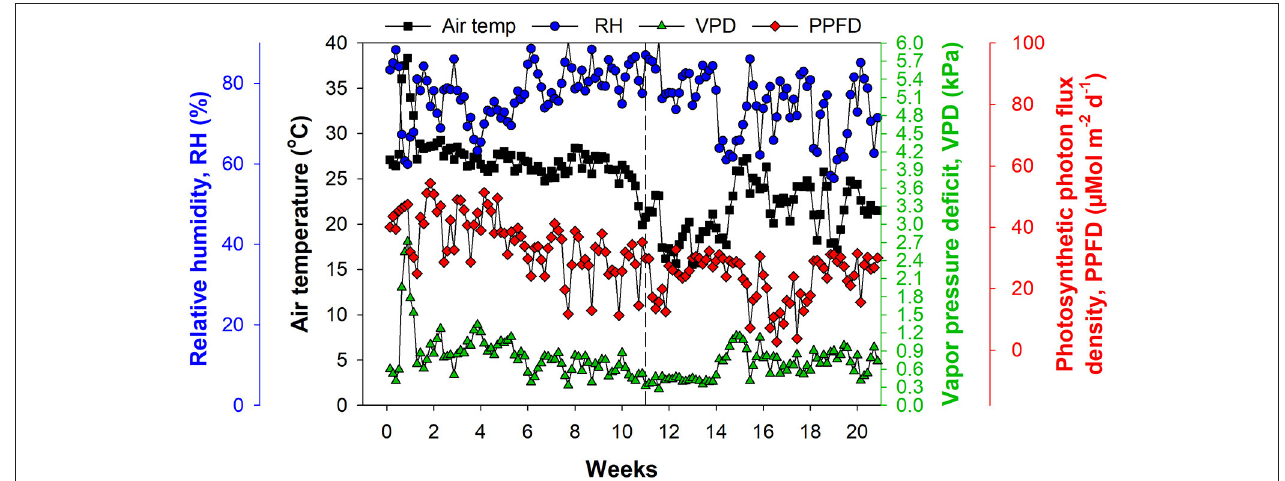
FIGURE 1 | Environmental conditions inside the greenhouse with double-layer plastic roof and polycarbonate sides, equipped with a heater and pad–fan cooling system. The dashed line at Week 11 represents 12 November, 2019 and indicates the beginning of the experiment.